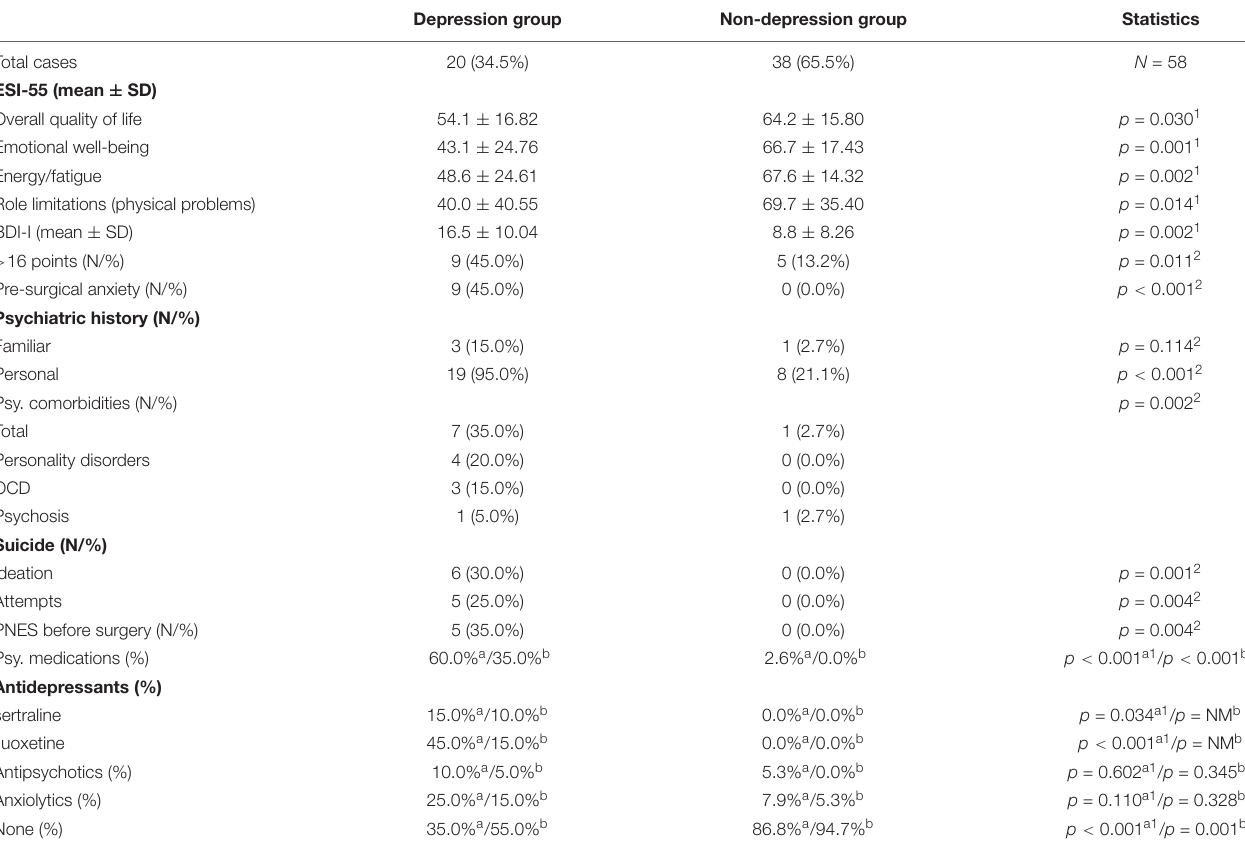
TABLE 2 | Psychiatric and quality-of-life profile of this series of patients with mesial temporal lobe epilepsy and hippocampal sclerosis, with and without comorbid depression. Depression group Non-depression group